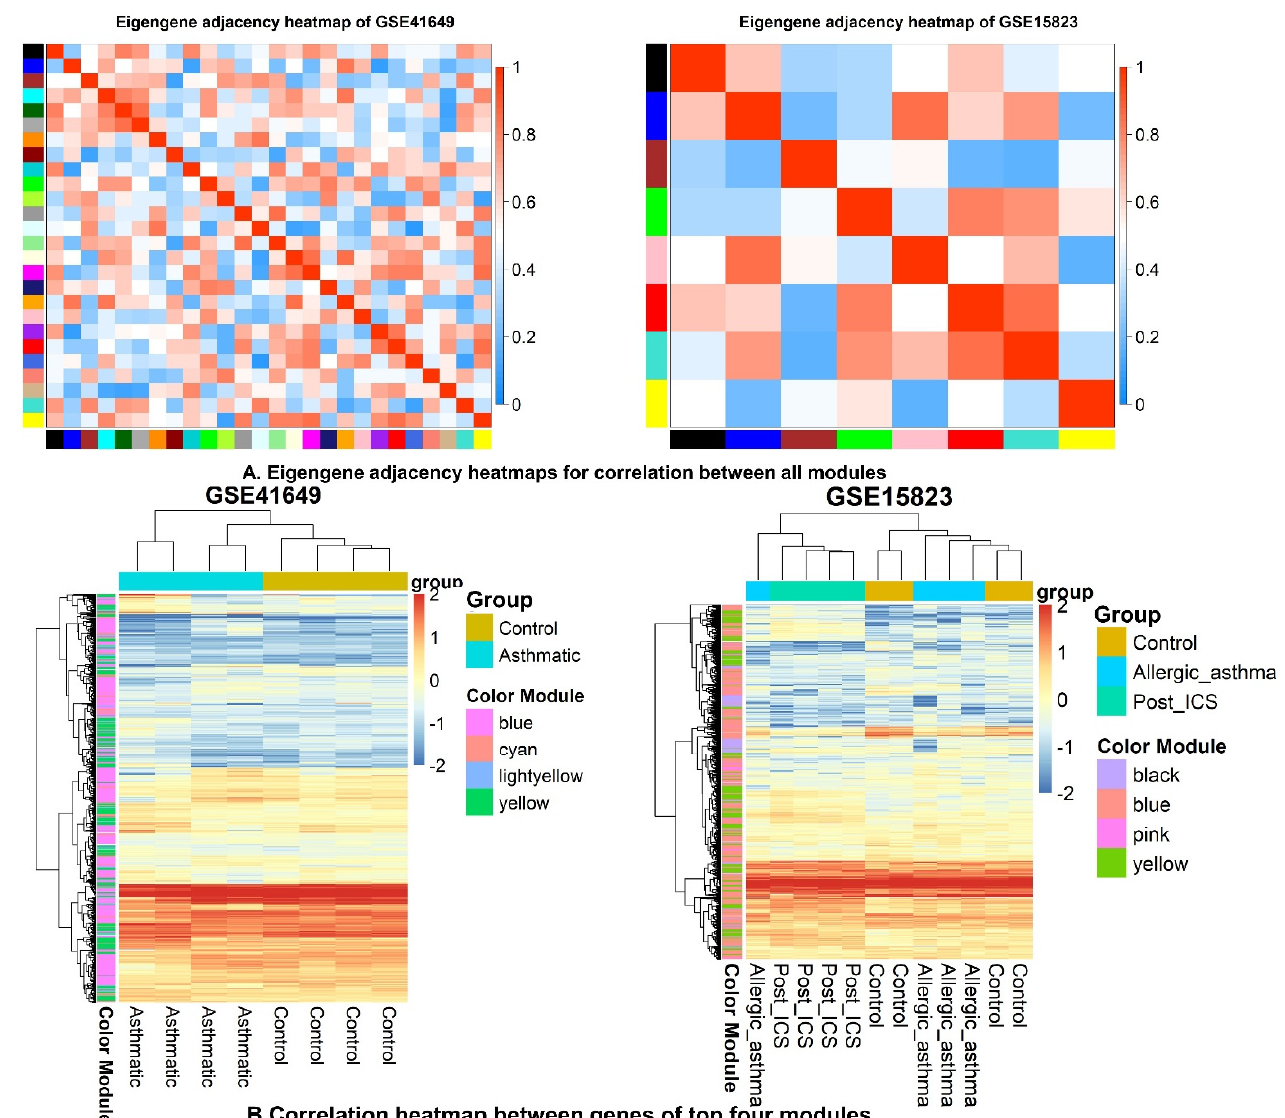
Figure 8. Correlation association between WGCNA modules. ( A ) Eigengene adjacency heatmaps for correlation between WGCNA modules. ( B ) Correlation heatmap between top four modules.